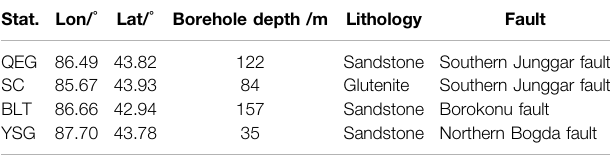
TABLE 1 | Basic data of the borehole stations